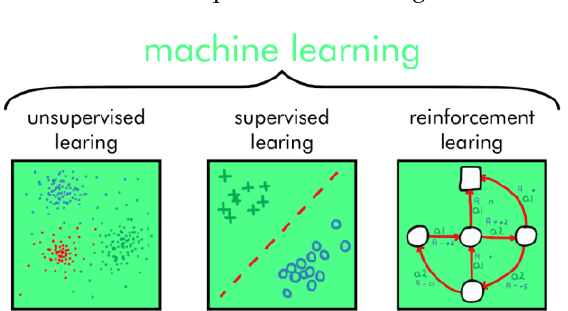
Figure 16. Machine learning categories (Adapted from [23,24]).